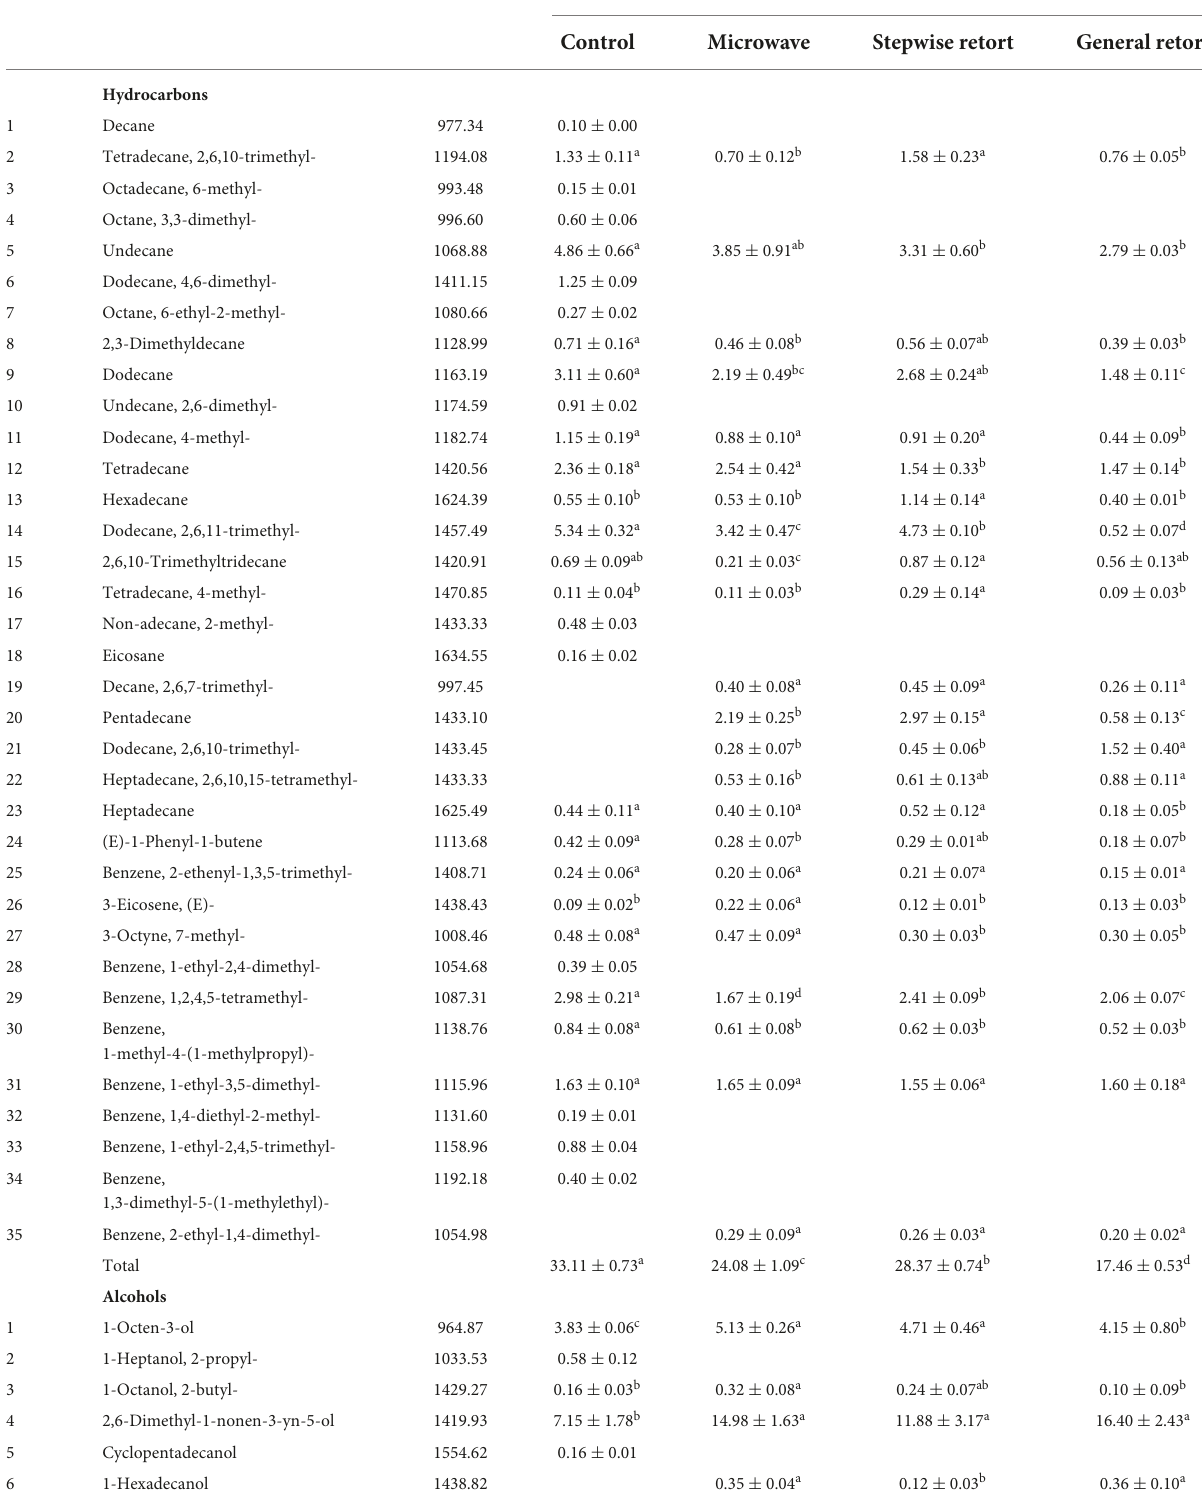
TABLE 3 Volatile flavor substances of duck meat treated with no thermal sterilization and three sterilization strategies.